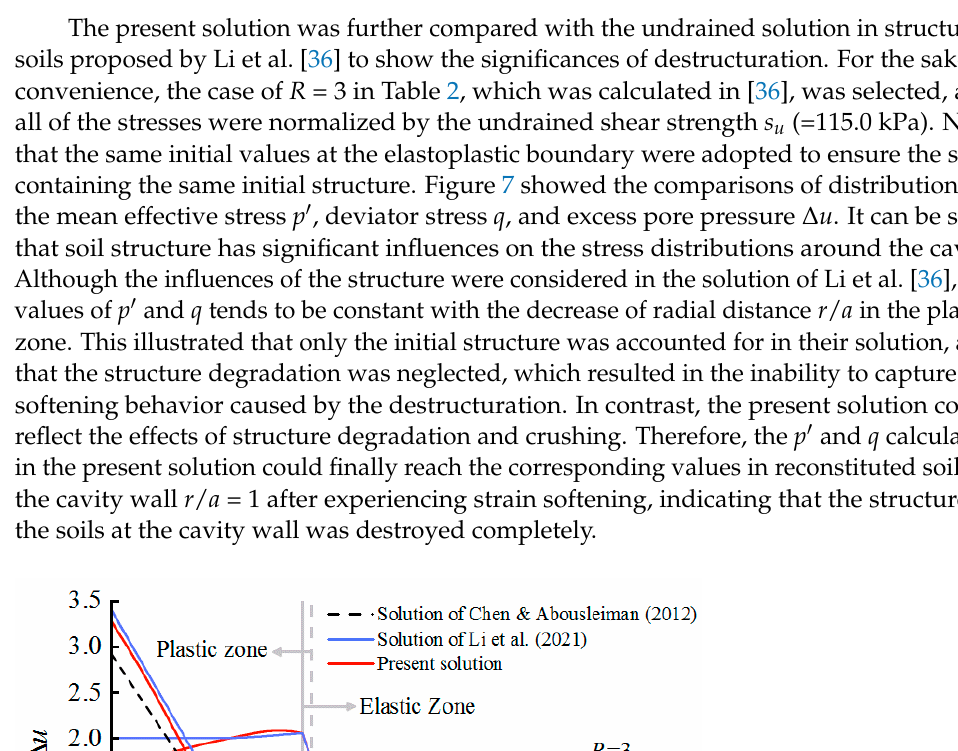
Figure 6. Comparison between the present solution and existing solution in reconstituted soils: ( a ) distributions of σ ′ r , σ ′ θ , σ ′ z , and Δ u along r / a ; ( b ) the p ′ – q stress path.